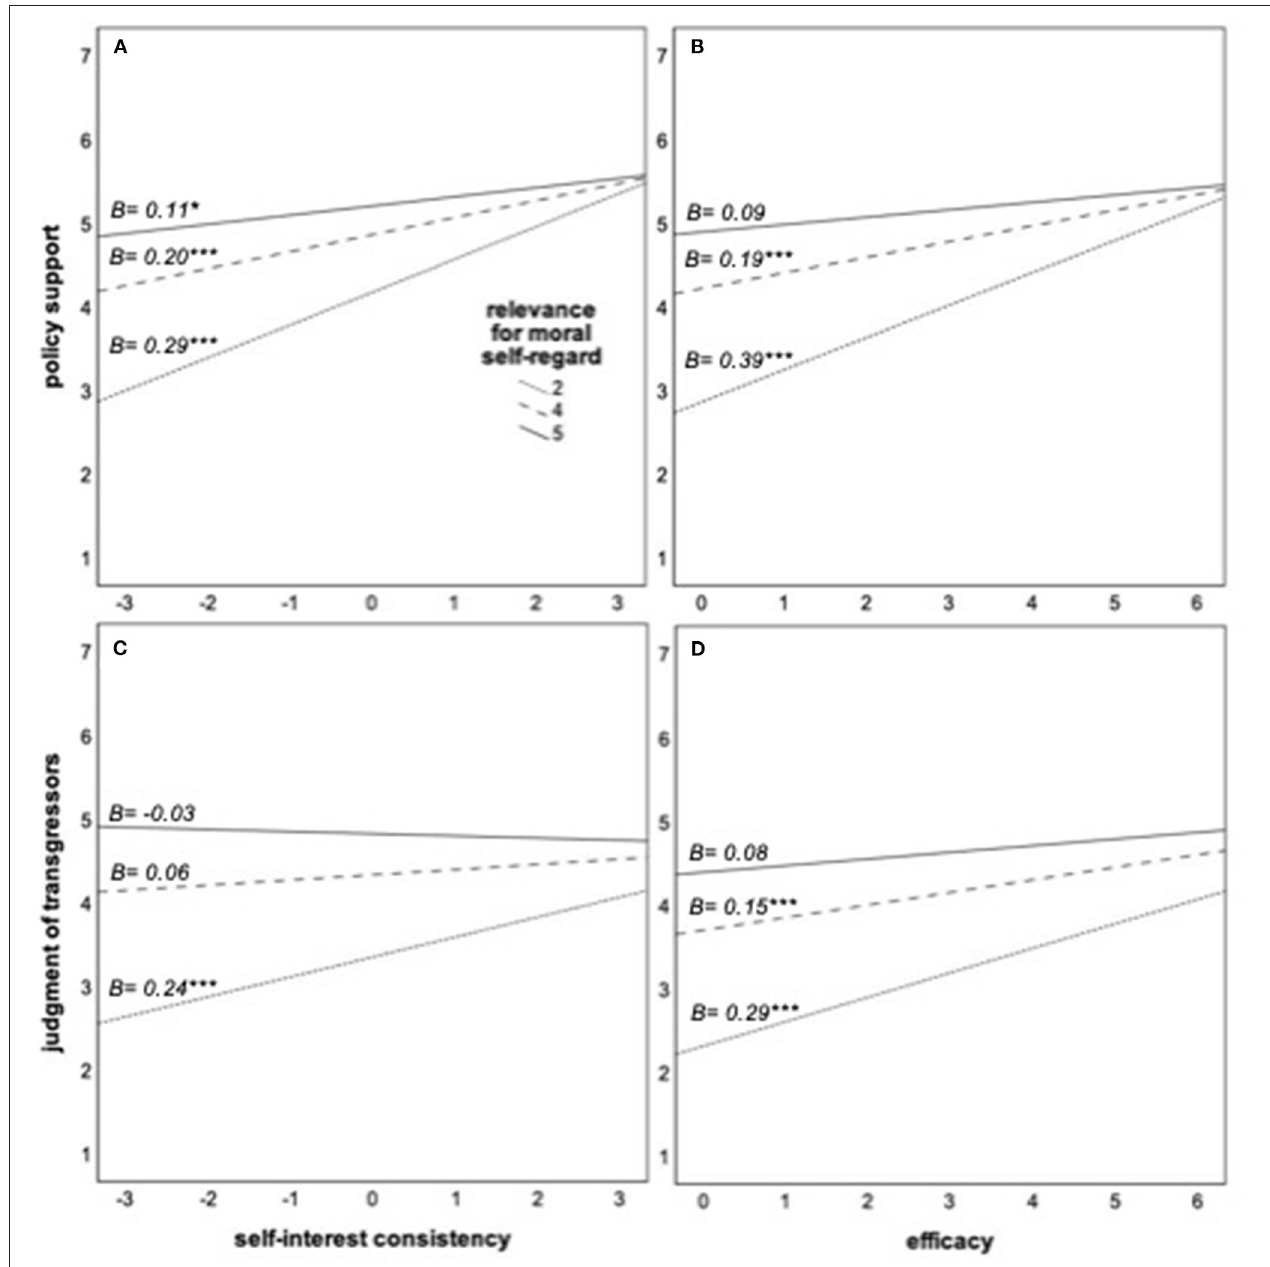
FIGURE 4 | (A–D) Role of self-interest consistency and efficacy of health measures for enforcement policy support and judgment of non-compliant others at different levels of the relevance of complying for moral self-regard. The slopes represent the estimated conditional effects at the 16, 50, and 84th percentiles of the